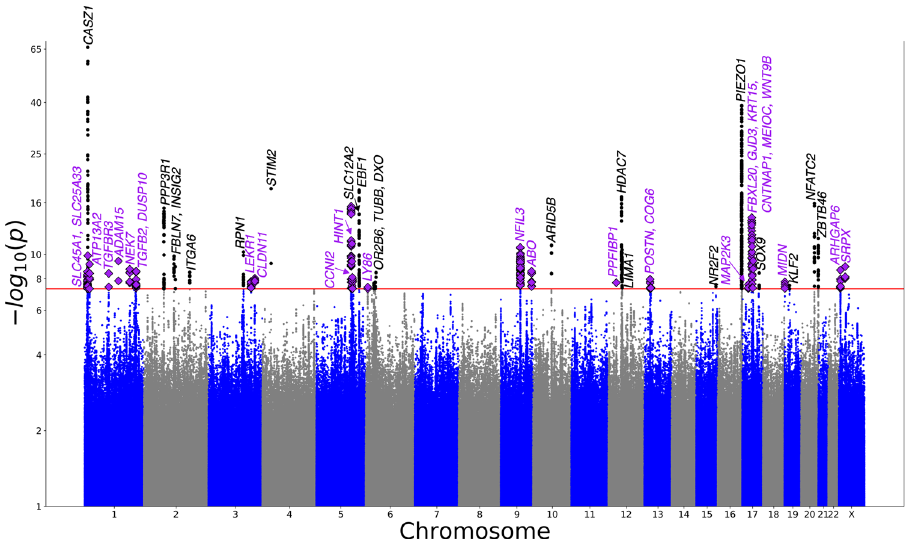
Fig. 1 VV Manhattan plot. Summary of the VV GWAS results from the sex-combined GWAS of the FinnGen cohort showing the − log 10 -transformed P value of each tested variant along the logarithmic vertical axis and base-pair positions along the chromosomes along the horizontal axis. The genome- wide signi fi cant variants in novel and known loci are indicated by diamonds in magenta and black points respectively. The red line signi fi es the genome- wide signi fi cance threshold of P = 5.0 × 10 − 8 . Table 2 Summary of the VV lead SNPs for novel loci and their colocalized